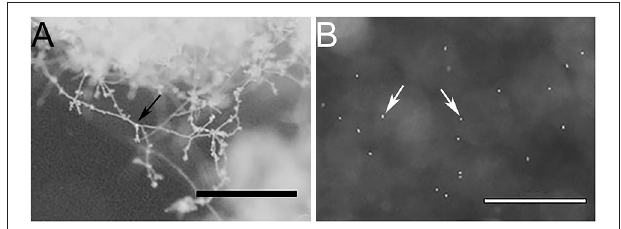
FIGURE 1 | Stereo microscope images of (A) a mycelial mass, and (B) free swimming zoospores, indicating minimal to no cross contamination between cell types. Bars represent 1mm scale. Black arrow indicates mycelia and white arrows indicate